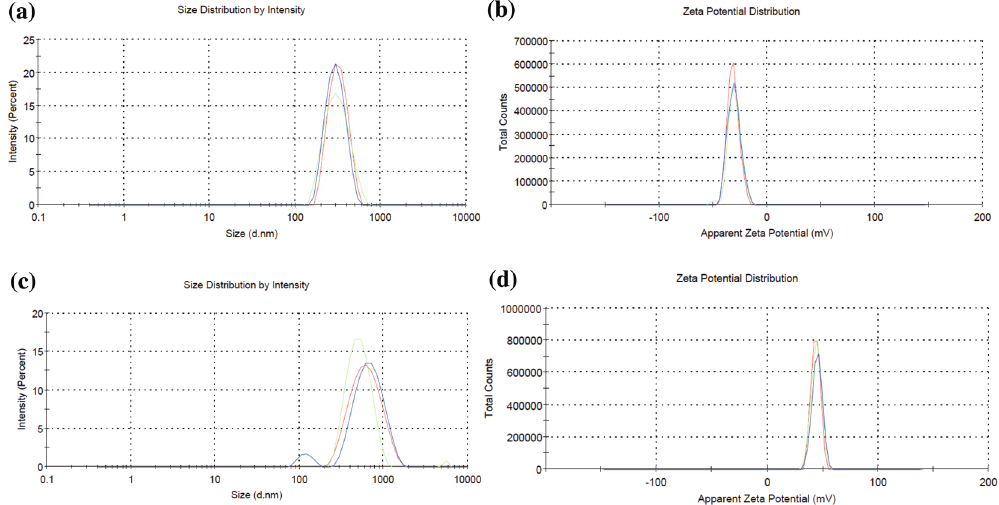
Figure 2. Characterization of PolyRad nanoparticles. ( a ) Size of melatonin encapsulated PLGA nanoparticles; (b) Zeta potential of melatonin encapsulated PLGA nanoparticles; (c) size of melatonin-PLGA-PLL-Trolox conjugates; and (d) Zeta potential of melatonin-PLGA-PLL-Trolox conjugates. The three colors in each graph represent three independent experiments.